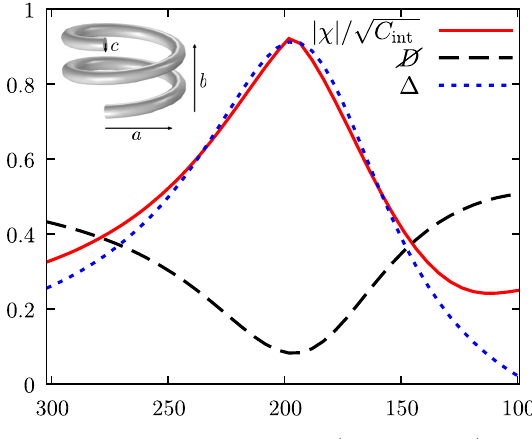
ffiffiffiffiffiffiffiffi p C , measure of duality int